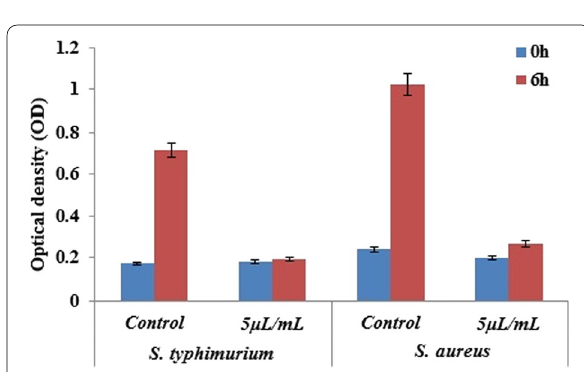
Fig. 7 Changes of optical density of bacteria, grown without (control) and with addition of GS Ag NPs (p <